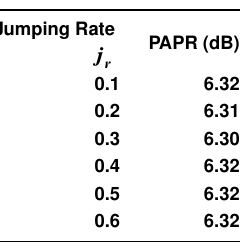
Table 2. Comparison of computational complexity for CCDF D 10 (cid:0) 3 among different jumping rate values. The smaller value is in bold font.